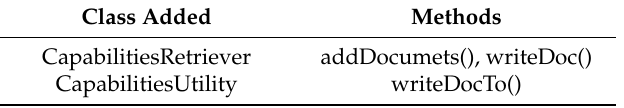
Figure 5. Changes to the invoke method. Table 3. Additional classes added to the server package.